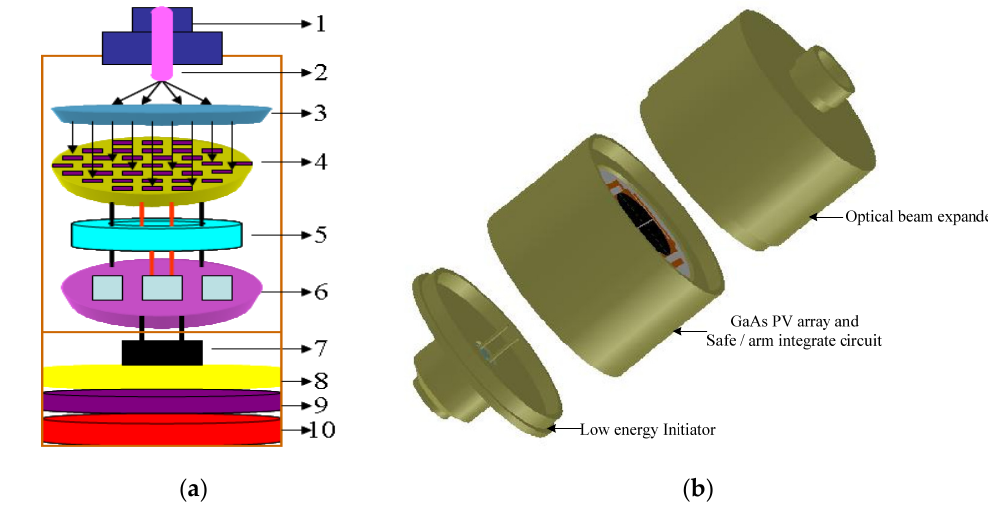
Figure 2. Schematic diagram of an LCEID. ( a ) Module composition.:1—FC/PC; 2—fiber; 3—optical beam expander; 4—GaAs PV array; 5—stored energy circuit; 6—safe-and-arms control integrated circuit; 7—SCB; 8—lead styphnate; 9—lead azide; 10—HMX. ( b ) Integrated structure.